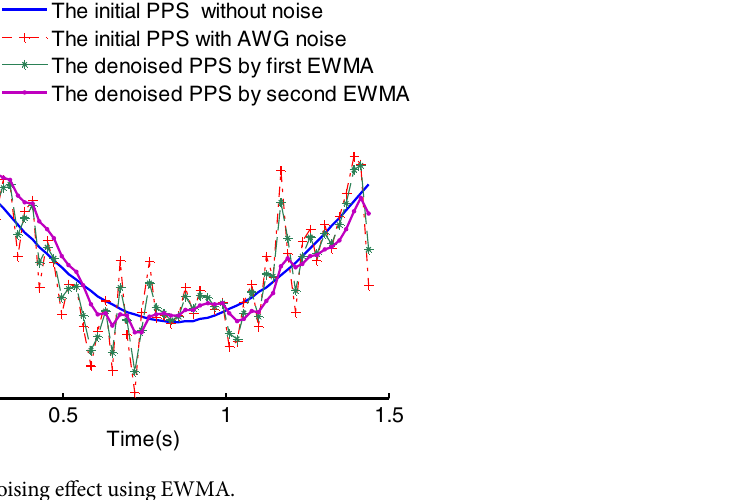
Figure 1. The denoising effect using